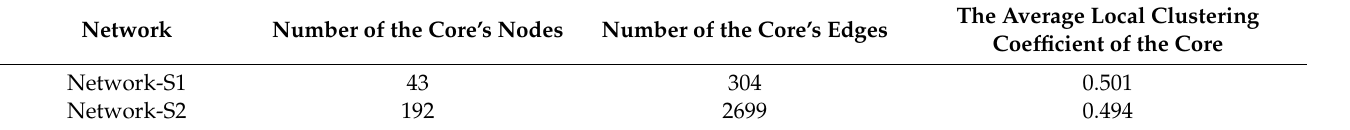
Table 2. Metrics for the Cores of the Two